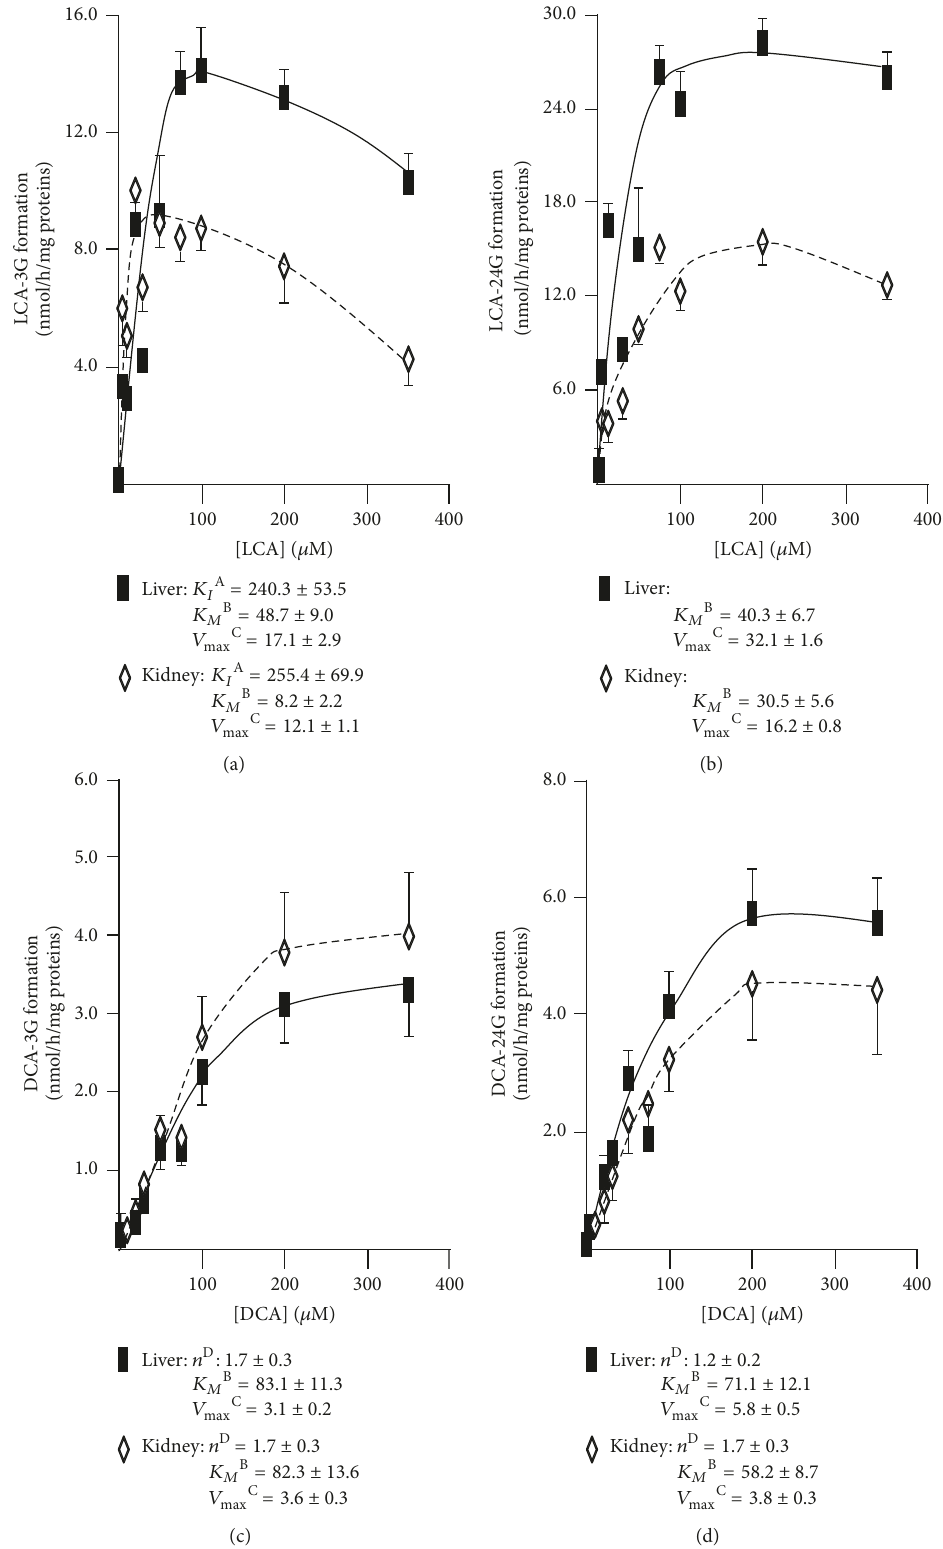
Figure 4: Kinetic analyses of LCA-3G (a), LCA-24G (b), DCA-3G (c), and DCA-24G (d) formation by microsomes from human liver and kidney. Human liver (black squares, pool of 50 donors) and kidney (white diamonds; pool of 8 donors) microsomes (10 𝜇 g) were incubated in the presence of increasing concentrations (1 to 350 𝜇 M) of lithocholic acid (LCA, (a) and (b)) or deoxycholic acid (DCA, (c) and (d)) for 2 hours at 37 ∘ C. The formation of LCA-3G (a), LCA-24G (b), DCA-3G (c), and DCA-24G (d) was analyzed by LC-MS/MS. For each panel, graphs represent the rate of product formation ( 𝑦 -axis) versus substrate concentration ( 𝑥 -axis) of two experiments performed in triplicate. The listed kinetic parameters were determined as indicated in “Materials and Methods.” A 𝐾 𝐼 : constant of inhibition expressed as 𝜇 M; B 𝐾 𝑀 : calculated Michaelis constant expressed as 𝜇 M; C 𝑉 max : calculated maximal velocity expressed as nmol/h/mg proteins; D 𝑛 : Hill